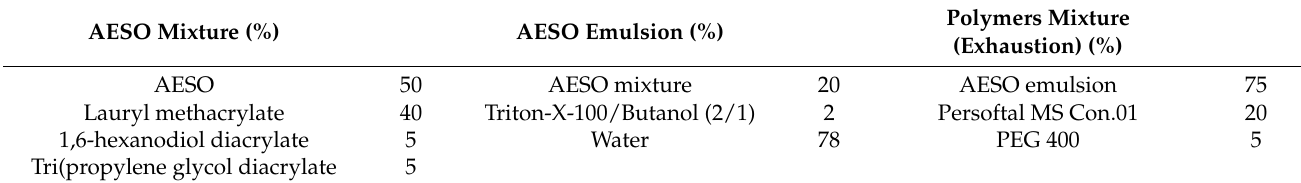
Polymers Mixture (Exhaustion) (%)